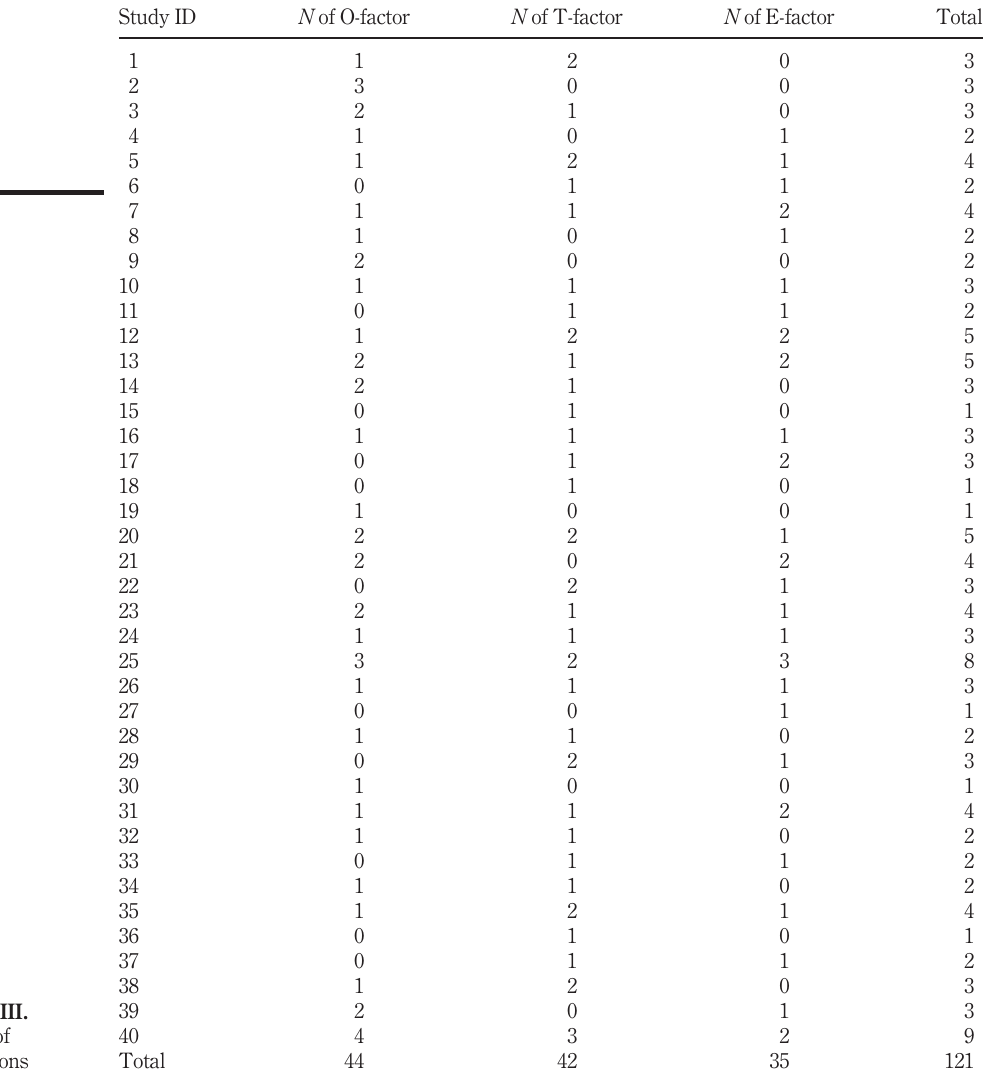
Table AIII. Number of